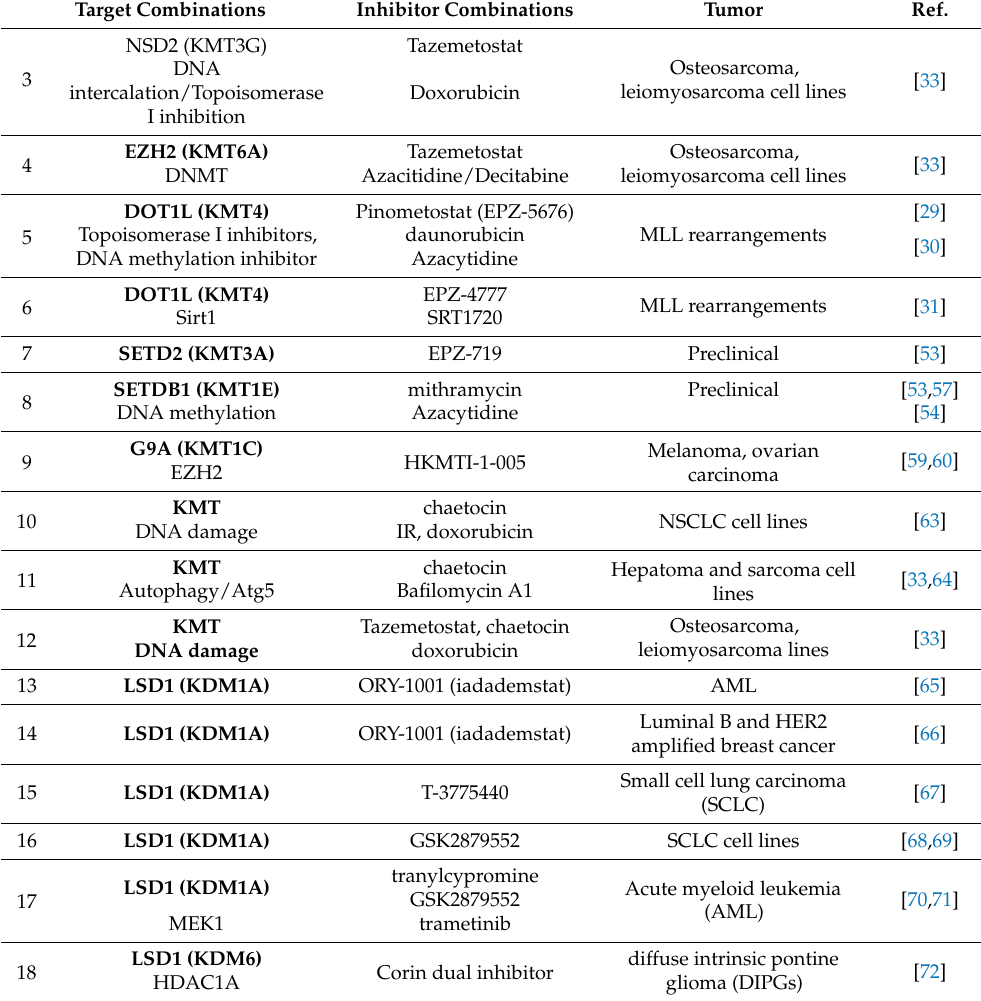
Table 1. Cont . Target Combinations Inhibitor Combinations Tumor